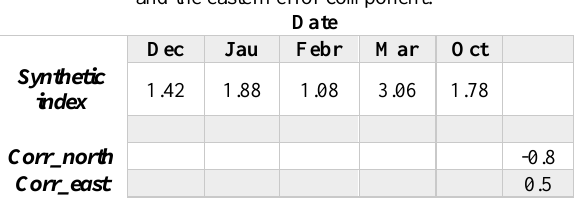
Figure 6. Correlation plot between camera calibration paramaters and principal components extracted by processing the dataset acquired in February. F: focal length; Cx and Cy coordinates of the principal point offset; B 1 , B 2: Skew